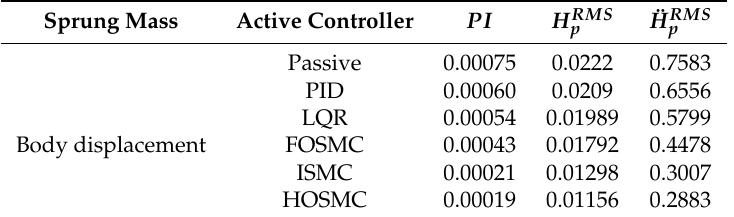
Table 3. Performance indices of different proposed active